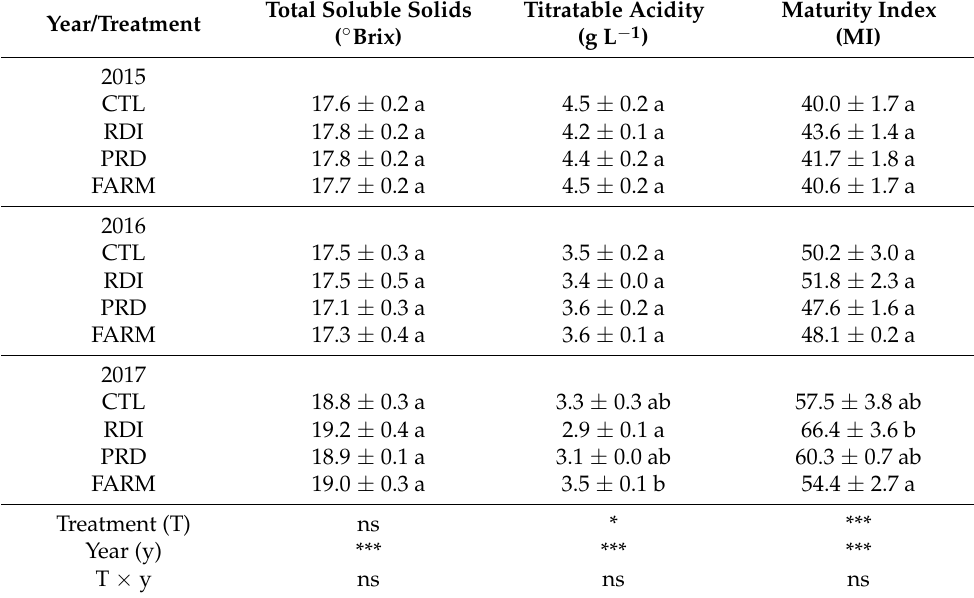
Means within columns for a given year, followed by a different letter were significantly different according to Duncan multiple range test ( p < 0.05). * and *** denotes significance at p = 0.05 and 0.001, respectively; ns = not